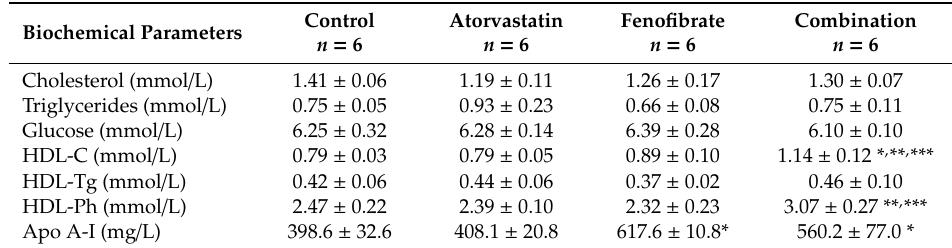
Table 1. Biochemical